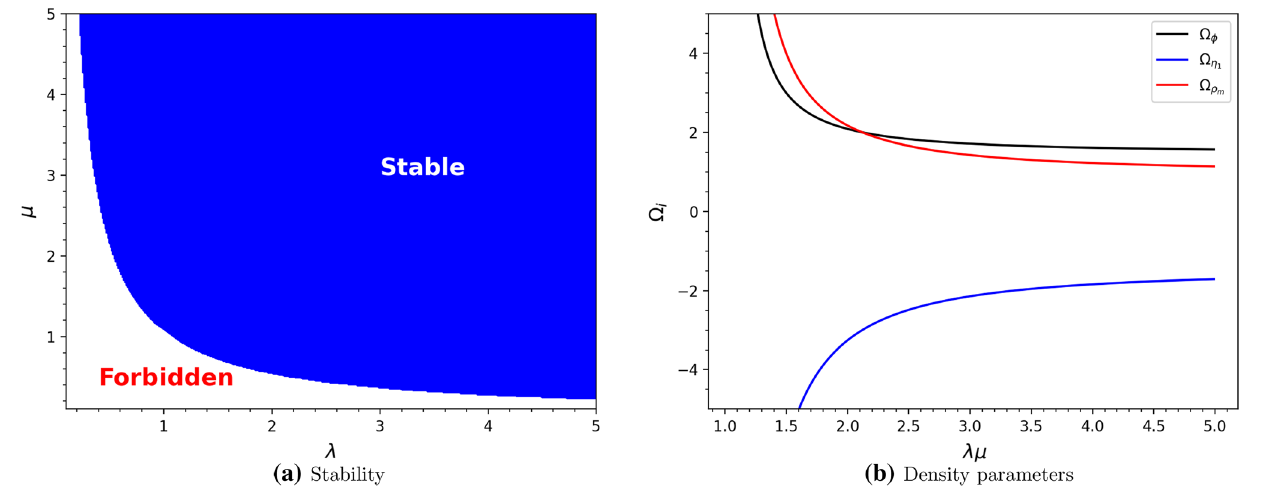
panel, the graph b illustrates the relation between density parameter of 2 non-vanishing fields and free parameters, i.e., λ and μ . The black, blue and red line in graph b indicates (cid:12) φ , (cid:12) η